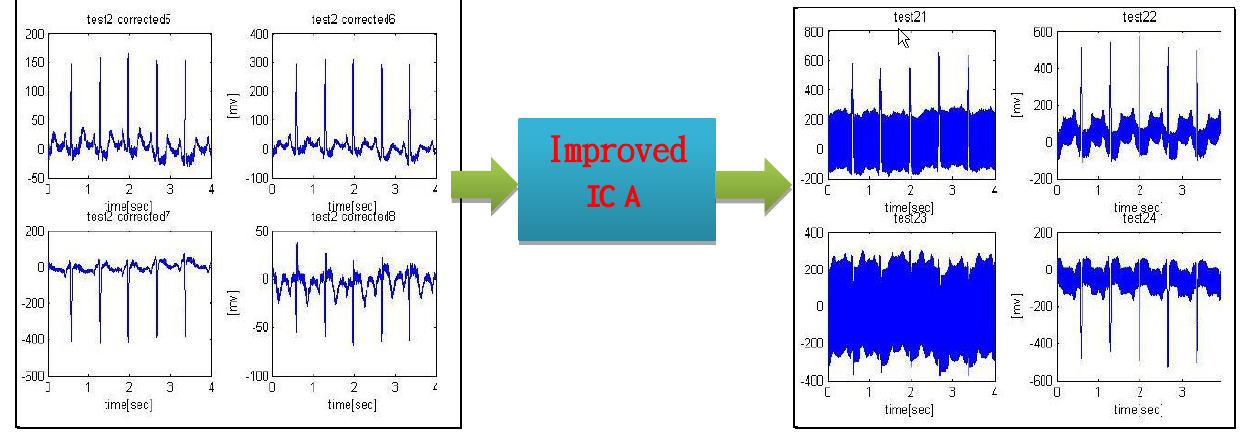
Figure 10. A superior physiological signal acquisition through an improved ICA algorithm (simulated by MatLab